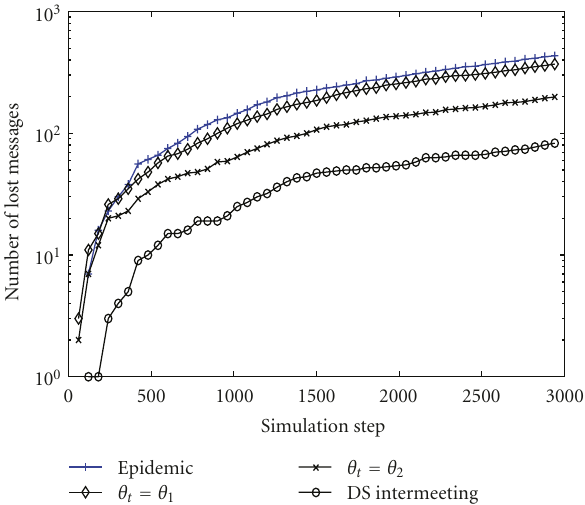
Figure 9: The random selection technique performance compared to the other techniques in terms of the number of forwarded messages.